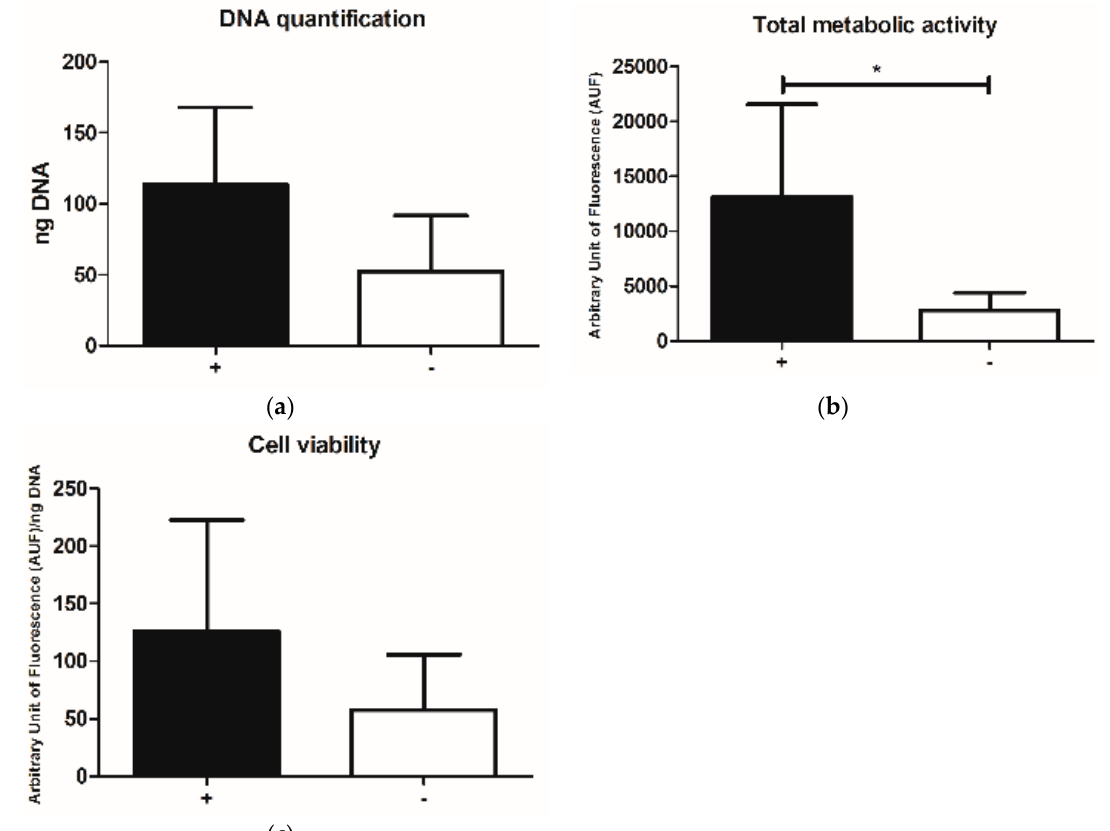
Figure 4. ( a ) DNA quantification, ( b ) total metabolic activity and ( c ) cell viability of samples grouped for the intermittent (+) vs. continuous ( − ) dynamic culture. Results are reported as mean ± SD. * p < 0.05.